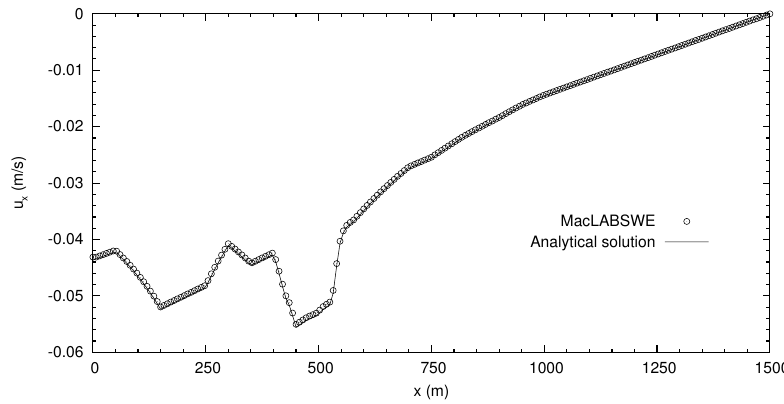
Figure 3. Comparison of velocity at t = 32,400 s when the flow is in the half-ebb tide with maximum negative velocities for 1D tidal